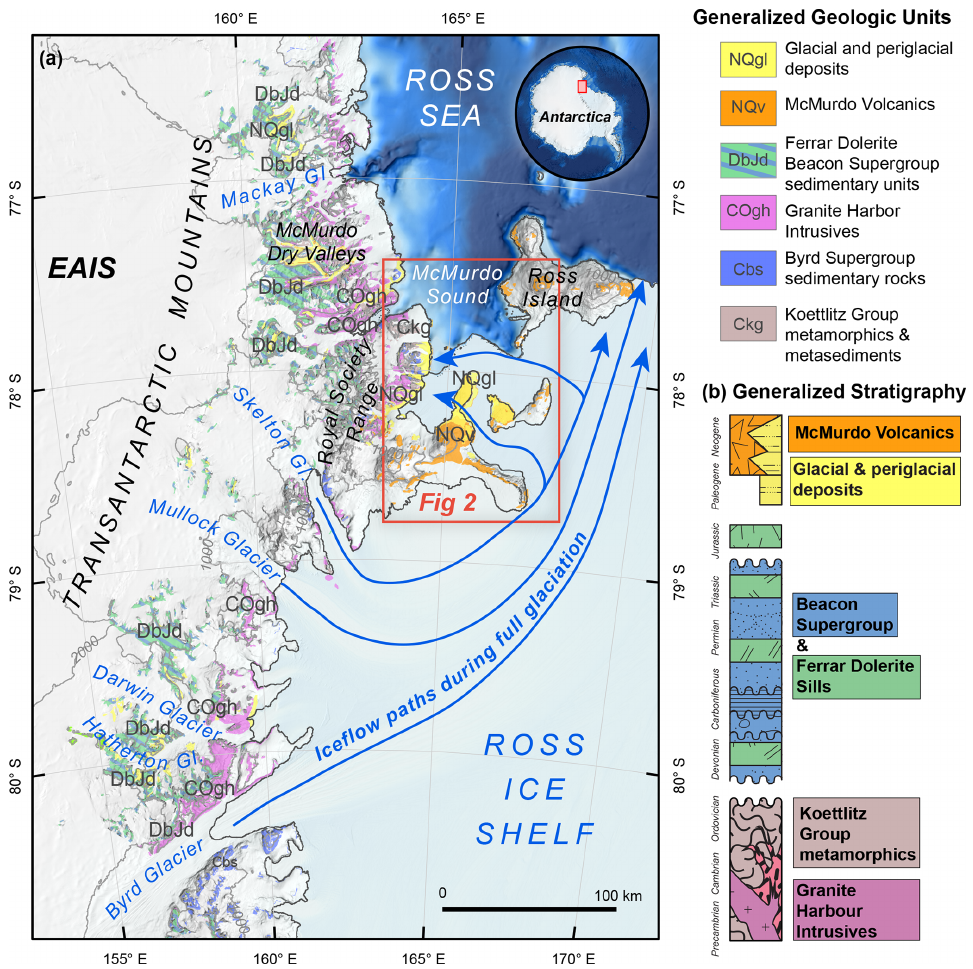
Figure 1. Bedrock geology and generalized stratigraphy of southern Victoria Land, Antarctica. (a) Regional overview map showing the generalized geologic units of southern Victoria Land, Antarctica. Blue arrows show the general flow directions of outlet glaciers when expanded into the Ross Sea. Base map uses data from the 2013 International Bathymetric Chart of Southern Ocean (Arndt et al., 2013) and the Reference Elevation Mosaic of Antarctica generated by the Polar Geospatial Center (Howat et al., 2019); generalized bedrock geology adapted from (Grindley and Laird, 1969; Warren, 1969). (b) Generalized stratigraphy of southern Victoria Land, Antarctica adapted from (Fitzgerald,